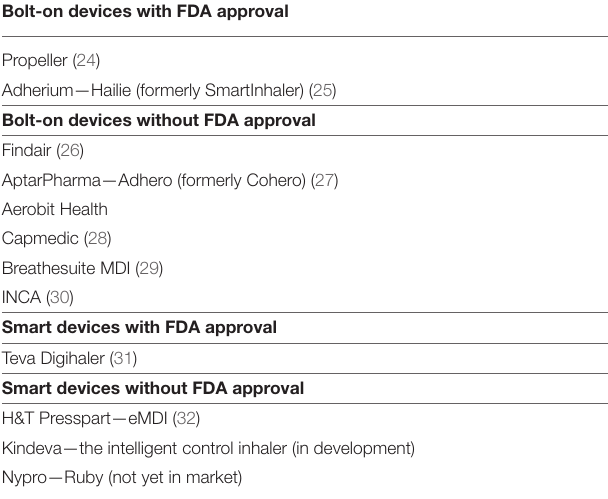
TABLE 1 | Bolt-on and smart